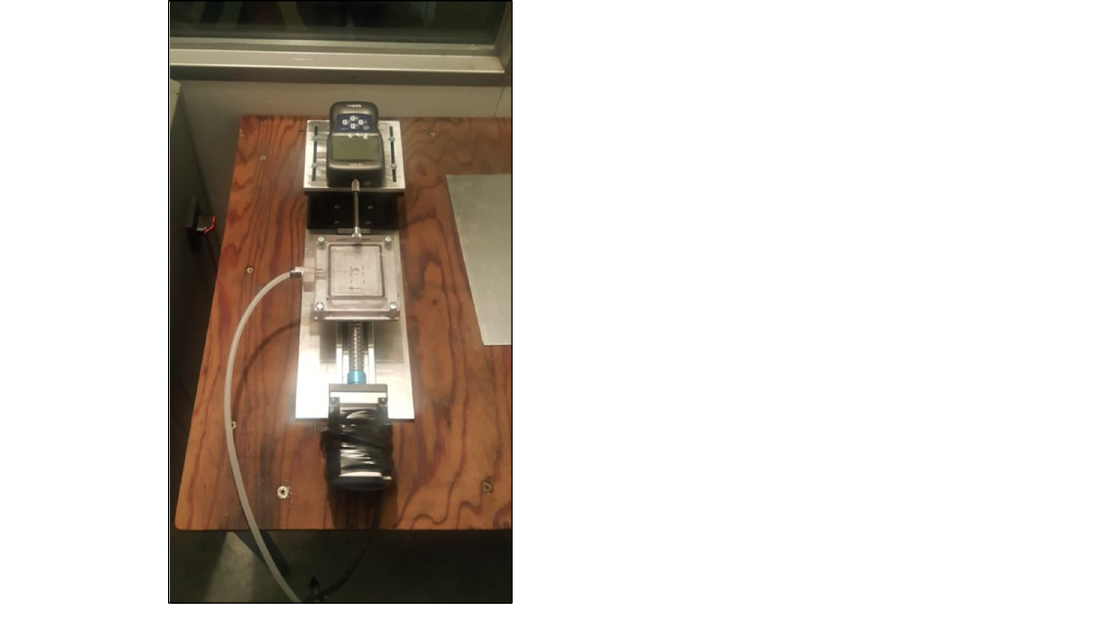
Figure 2. Overview of the push-off apparatus. The ice adhering to the coating is pushed off by the force gauge and evaluates the adhesion.